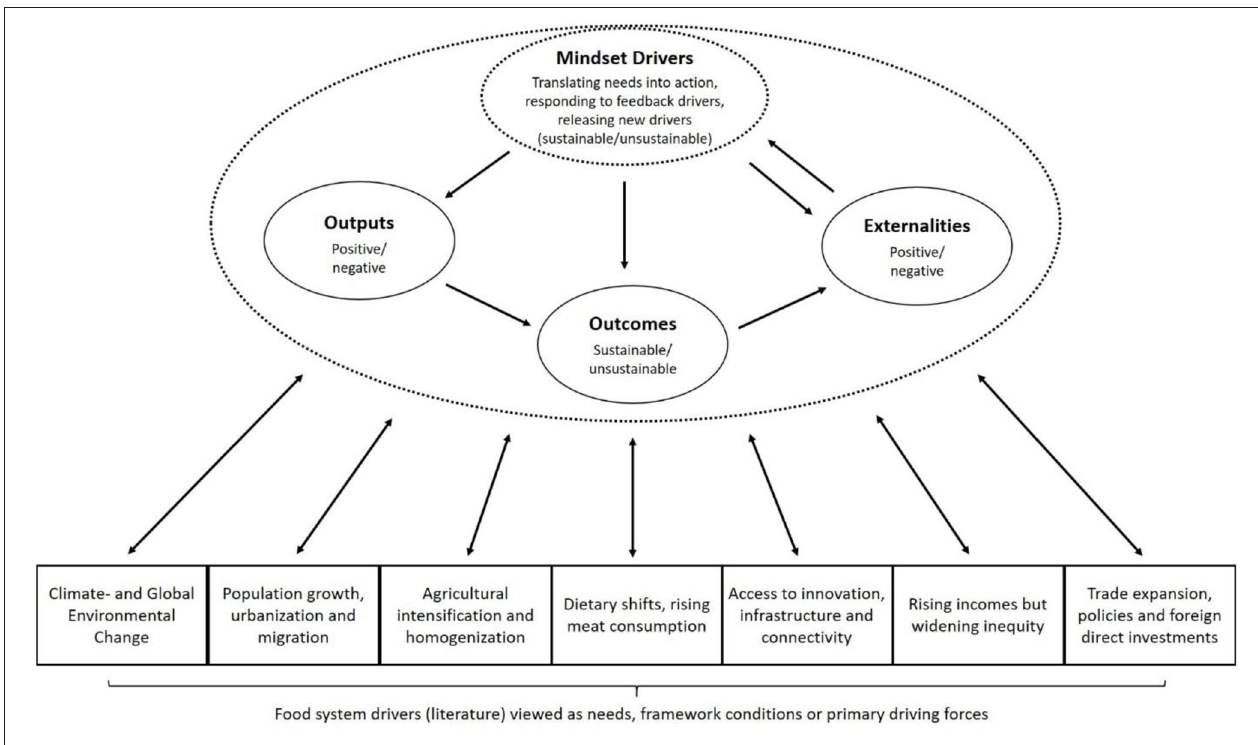
FIGURE 4 | Modified DPSIR framework portraying mindset as key driver of food systems, translating needs into action and resulting in different causal chains depending on mindset quality of the actor.